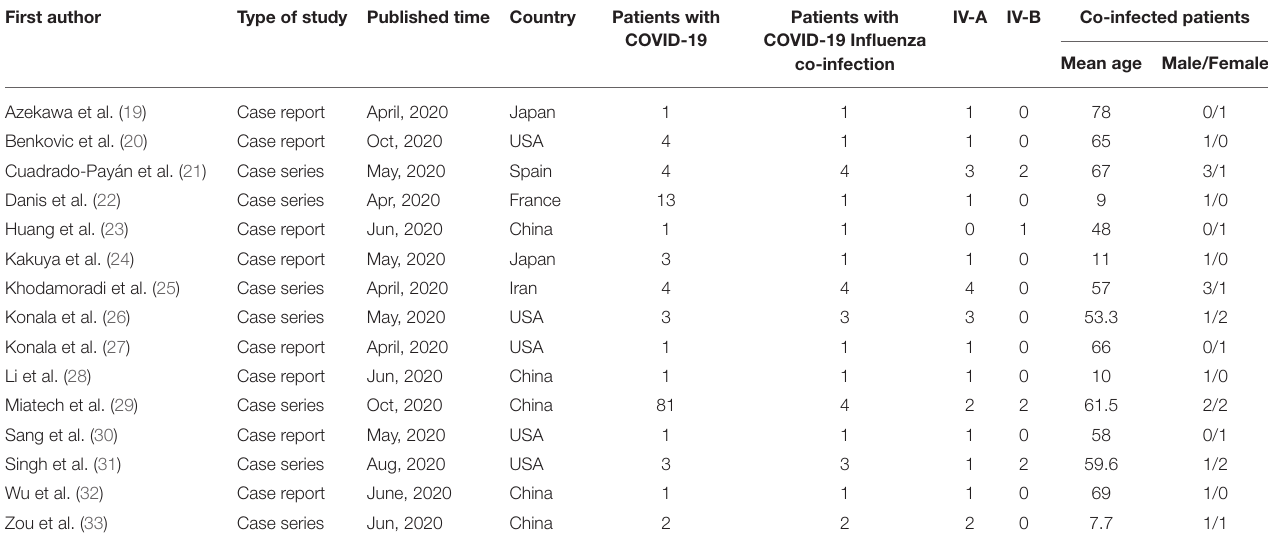
TABLE 2 | Characteristics of included case report/case